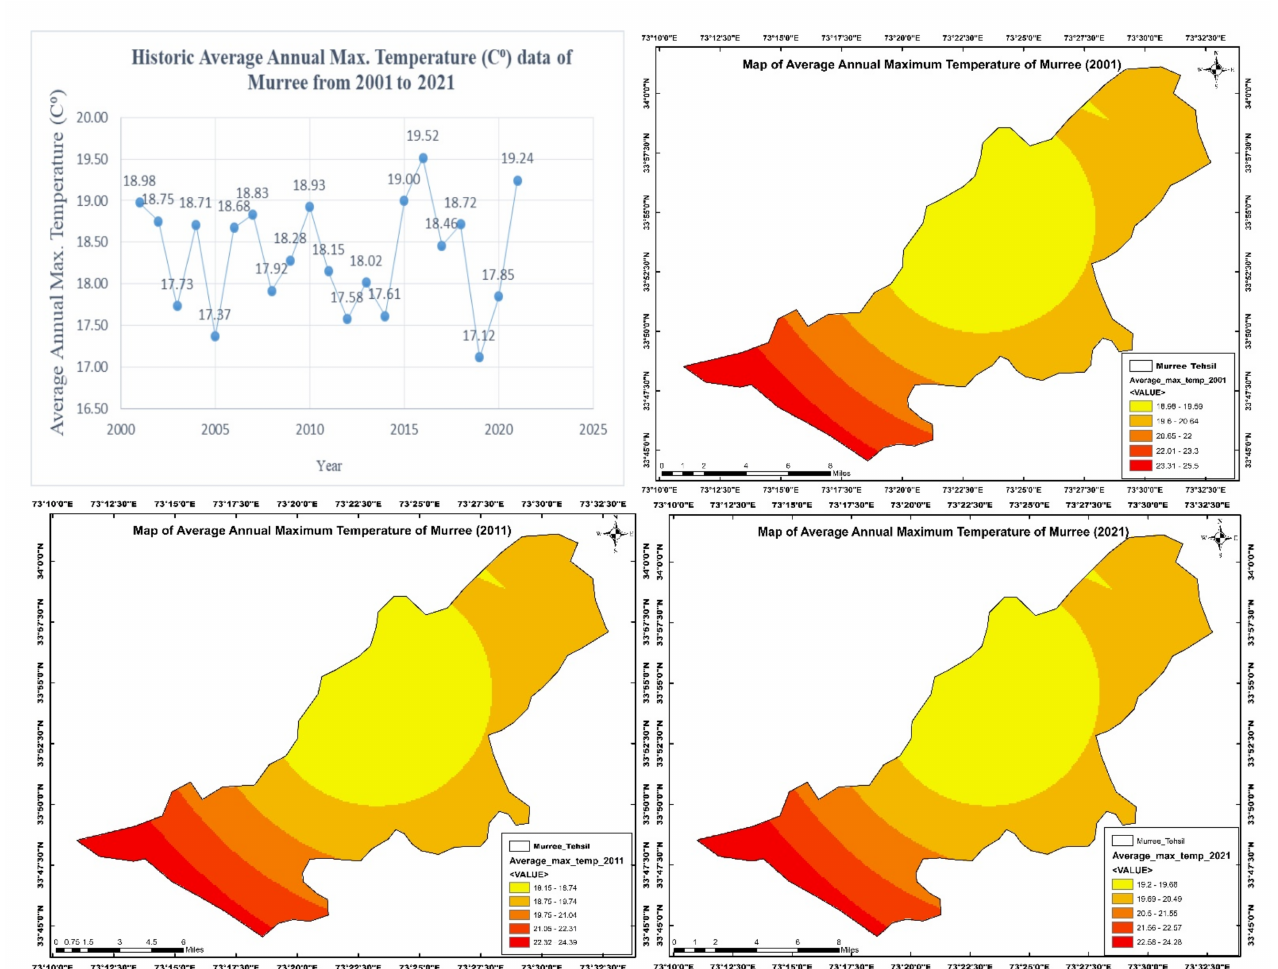
Figure 6. Average annual max. temperature ( ◦ C) data and temperature distribution of Murree from